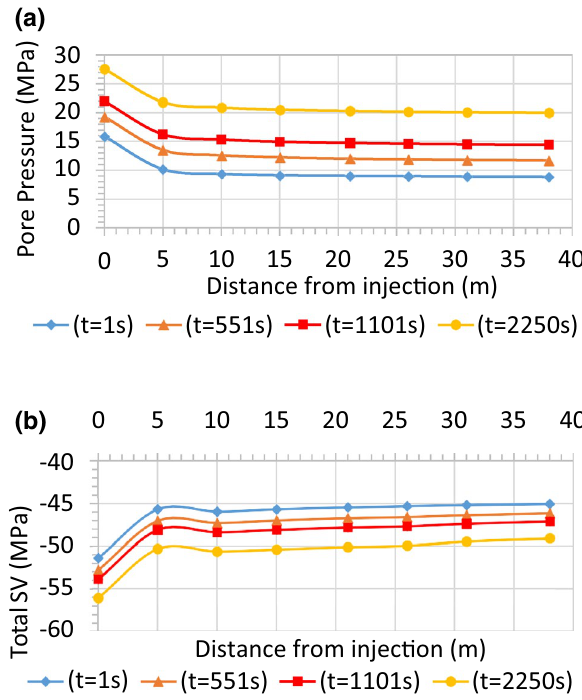
Fig. 10 Case 1 ( k = 23.4 mD): a Pore pressure versus distance and b total vertical stress versus distance along SRV height above injection ports at various injection times